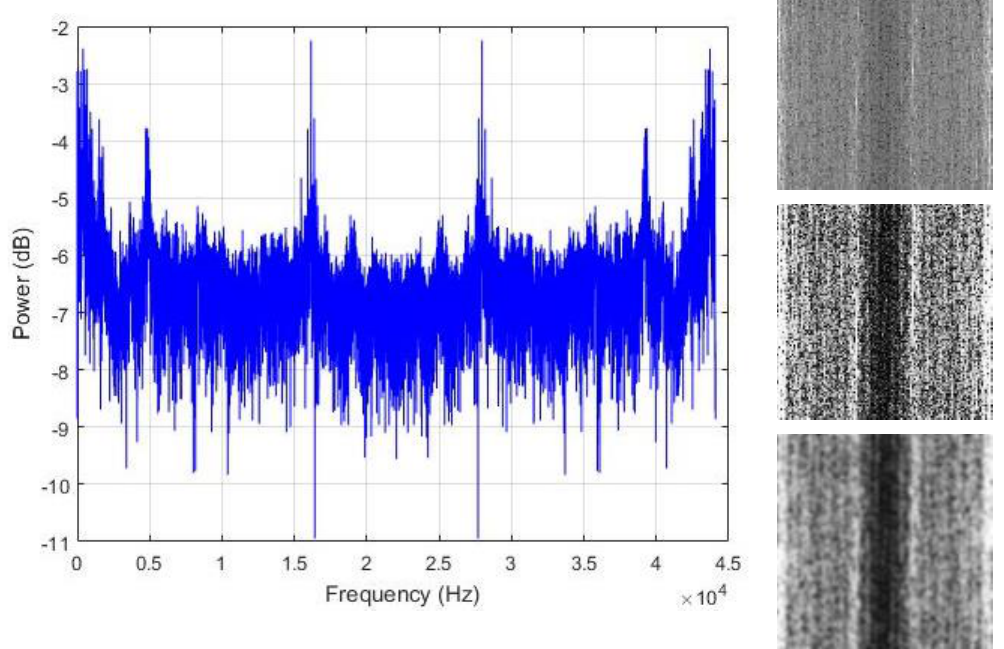
Figure 9. Left column: the power spectrum of an abnormal data sound; right column: the corresponding PSD-images. From top to bottom: the original image, the histogram equalized and the smoothed versions, respectively. The original size of the PSD-images shown here is 115 × 115.